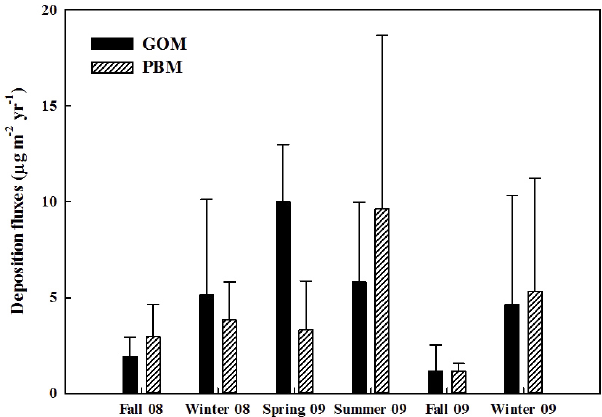
Figure 2. Seasonal variation in dry deposition flux for GOM and PBM under the deciduous